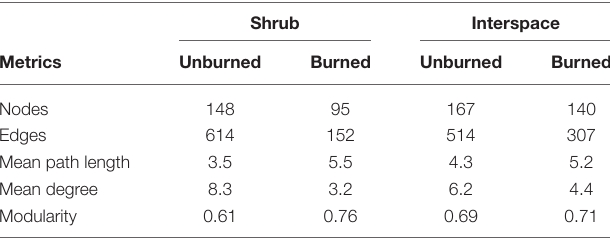
TABLE 1 | Metrics from network co-occurrence models of burned and unburned of Cyanobacteria/lichen-dominated crusts occupying relatively plant-barren interspaces (interspaces) and Cyanobacteria/moss-dominated crusts the beneath shrub-islands (shrub). Shrub Interspace Metrics